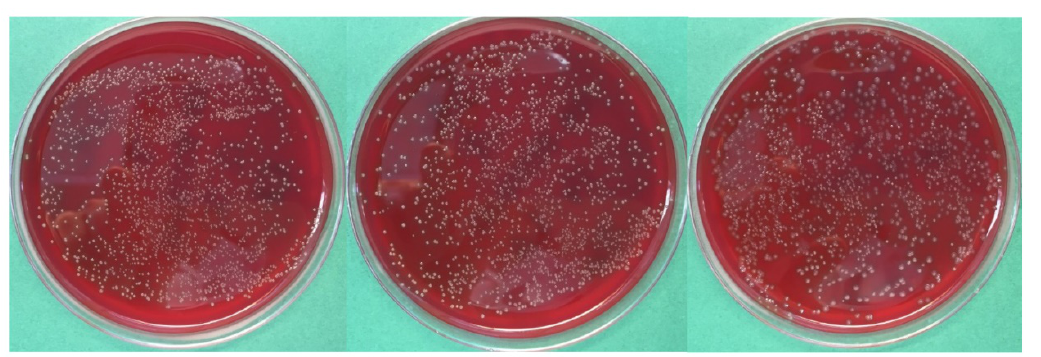
Figure 2 : Bacterial regrowth ( S. sanguinis , Copal G+C) after 0, 60 and 240 minutes after sonication (representative